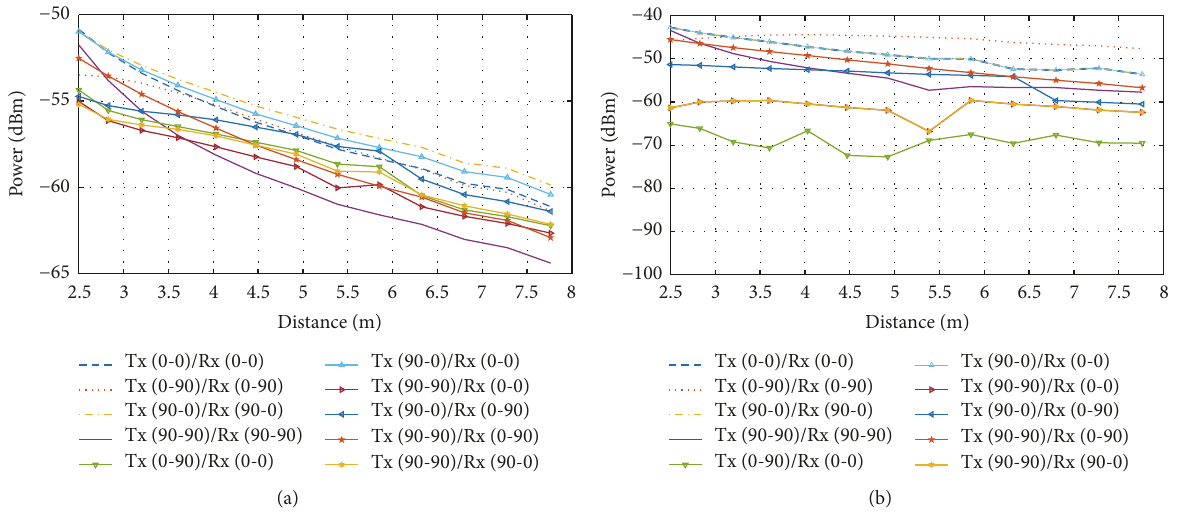
Figure 14: 𝑃𝑟 level for both antennas in the OLOS scenario: (a) 3D cubic antenna and (b) dipole